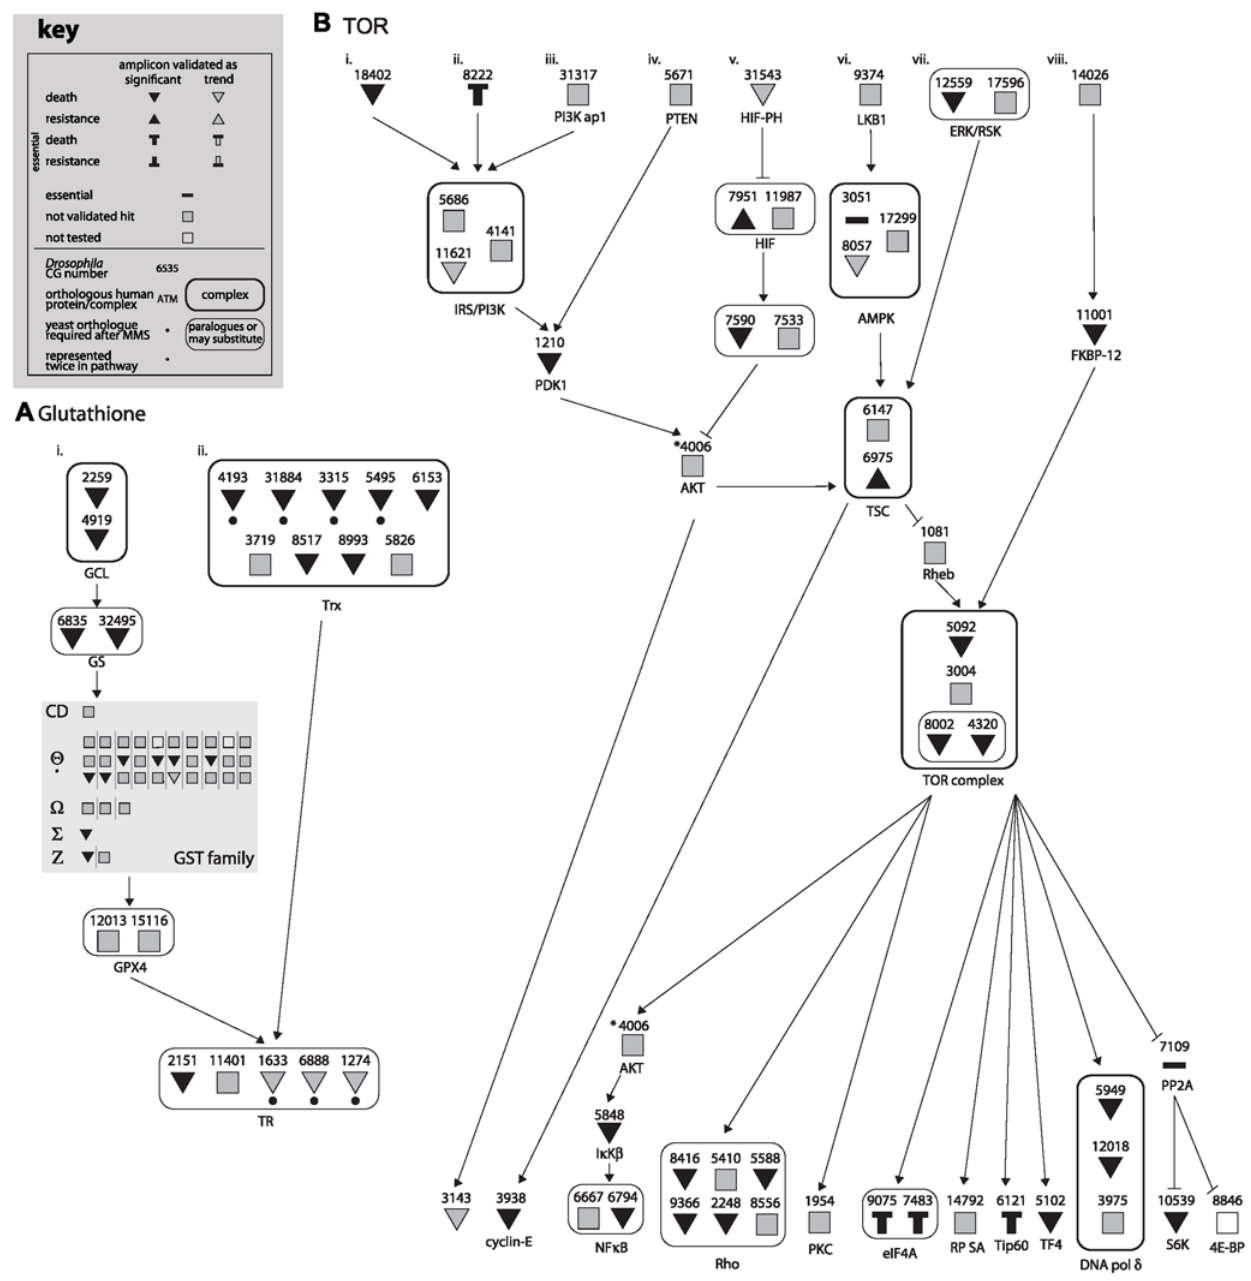
Figure 3. Glutathione and TOR pathways utilized for MMS survival. CG numbers are given for each Drosophila pathway component, as well as the protein names or complex names for their human orthologues. Pathway entry points are noted with Roman numerals at the top, and end points are at the bottom. A key for the following symbols is provided. Symbols encircled with thick lines represent proteins that act together or in a complex, while symbols encircled with thin lines represent paralogues or proteins that may substitute for one another. Proteins found to affect MMS survival are noted as down (death) or up triangles (resistance). Statistically significant proteins are indicated with black triangles, while trend hits are indicated with grey triangles. Essential genes are noted with a thick bar and any with downwards or upwards pointing boxes were also validated as conferring death or resistance, respectively, to MMS upon knock-down. Shaded squares are proteins not found to be hits after validation, and open squares were not tested in our validation. Yeast orthologues previously found to be required for MMS survival [3] are noted with a dot under the symbol. (A) Glutathione (an expanded list of GST family members is given in Table S4) and (B) TOR.